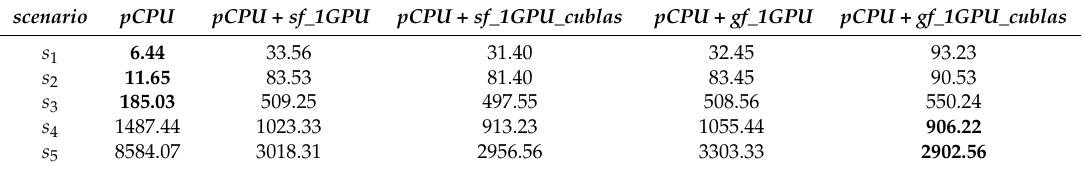
Table 4. Execution times (in seconds, for 10 iterations) in jupiter (the best time value for each scenario has been